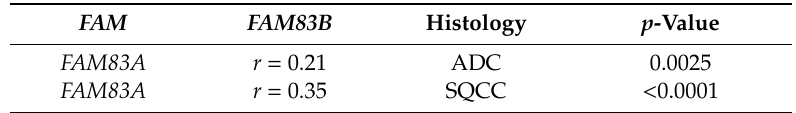
Figure 1. The FAMily with sequence similarity 83 ( FAM83 ) genes FAM83A and FAM83B are highly overexpressed in non-small-cell lung cancer (NSCLC). The waterfall plots depict the x-fold change expression of FAM83A and FAM83B in tumor vs. normal tissue. ( A ) FAM83A expression in all patient samples, ( B ) separated by histology, ( C ) and furthermore by gender; ( D – F ) corresponding plots for FAM83B . Equal expression of the genes in tumor and adjacent non-neoplastic tissue was set to 1 (dotted line); Ø = median overexpression. Table 2. Spearman correlation between FAM83A and B expression in the two main NSCLC histological types ADC and SQCC.